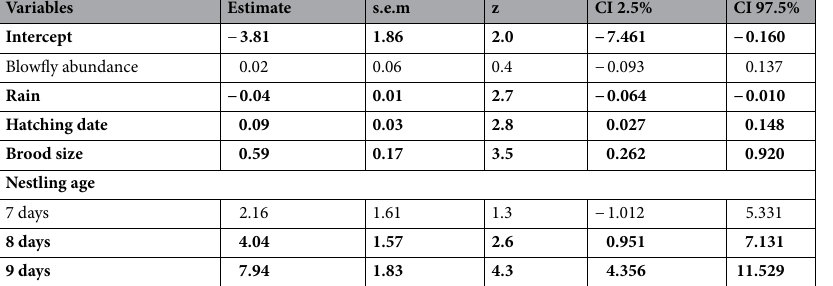
Table 4. Model-averaged variables best explaining the length of the 3rd primary feather (mm) of Wood Warbler nestlings (response variable). Shown are averaged coefficients and confidence intervals (CI) across models with ΔAICc < 2 (Table 3; conditional average). Significant relationships ( P < 0.05) are marked in bold. For the description of variables see Table 3.